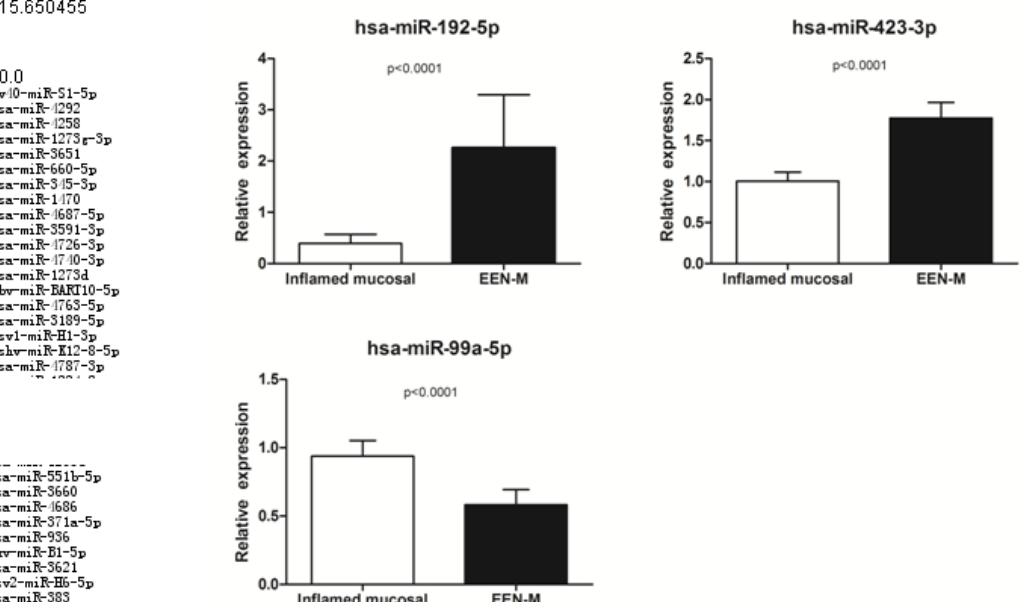
Figure 1. Comparison between inflamed mucosa of active CD and EEN-M: ( A ) heat map of differentially expressed miRNAs clearly separated inflamed mucosa and EEN-M; and ( B ) qRT-PCR validation of miRNAs differentially expressed in EEN-M. EEN-M, mucosa after exclusive enteral nutrition treatment.